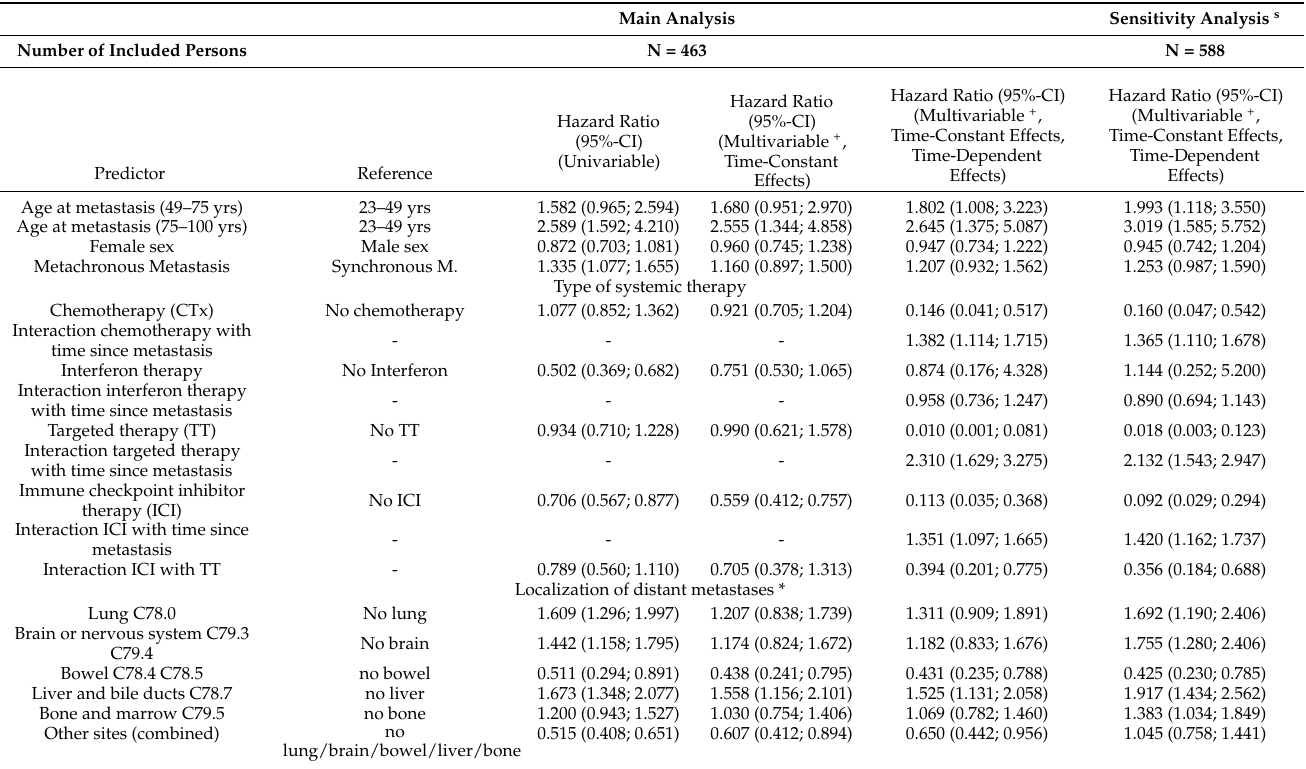
Table 3. Univariable and multivariable Cox regression models for time since first metastasis. Multivariable models were adjusted for age, sex, type and timing of metastasis, comorbidities, occupational position, occurrence of multiple localizations of distant metastases, and influenza vaccinations prior diagnosis of melanoma weighted for personal time under risk. Because the systemic therapies showed a violation of the proportional hazard assumption, time-varying effects were included in the cox model (log function was used). This allowed the survival rates of the therapies to intersect over